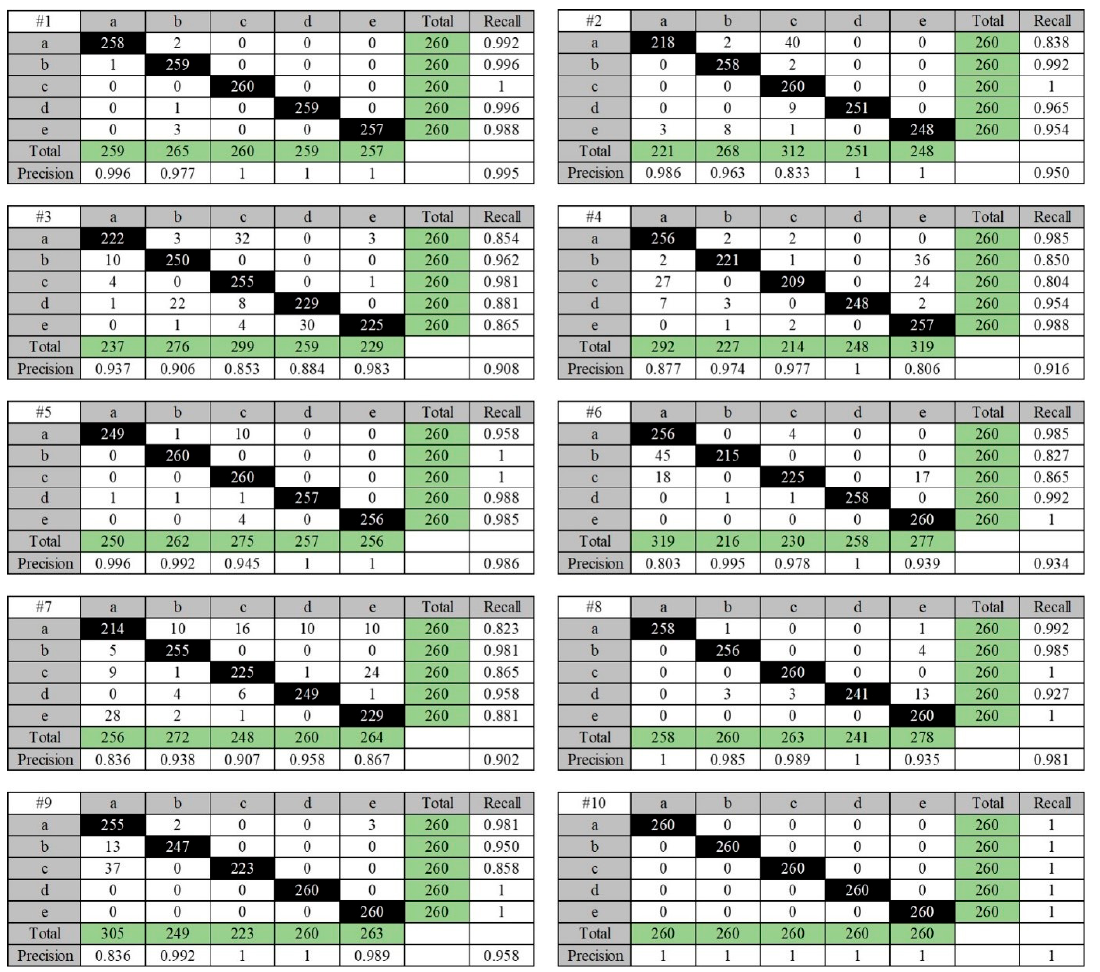
Figure 9. The results of confusion matrix for each participant.